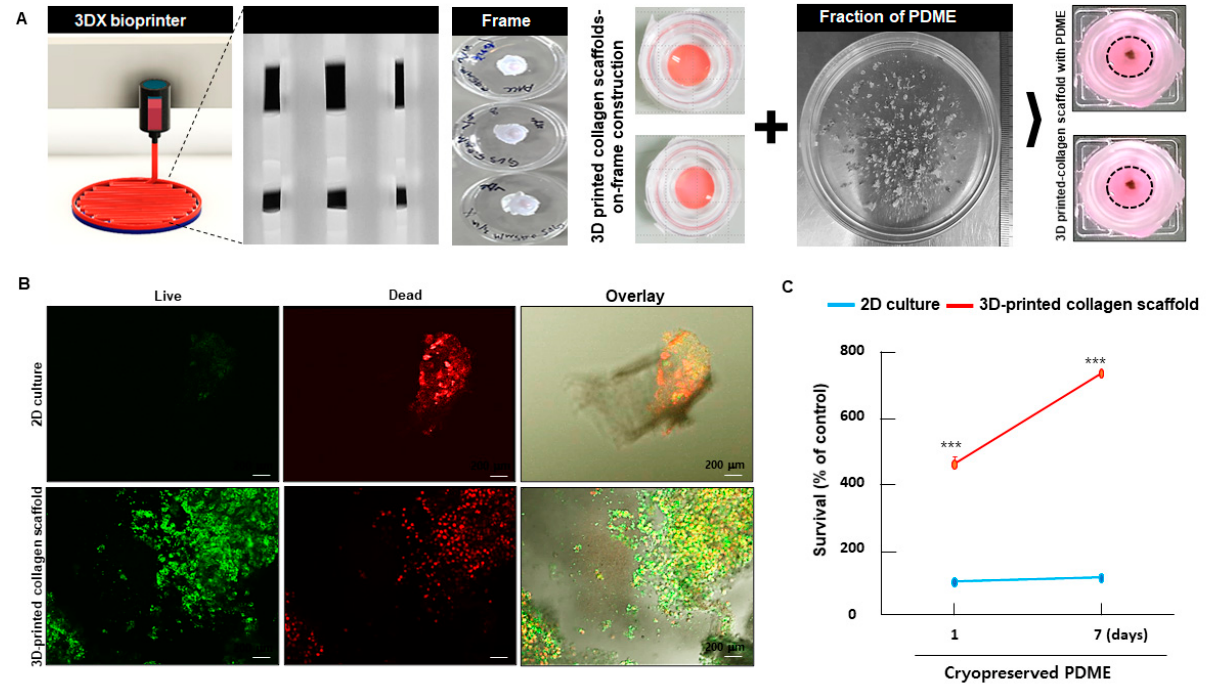
Figure 2. The effects of 3D-printed collagen scaffolds on 3D culture model of cryopreserved PDME. ( A ) Manufacturing process of 3D-printed collagen scaffolds loaded with cryopreserved PDME. Two layers of collagen-on-frame construction were printed by a 3DX bioprinter. ( B ) Confocal images for visualizing live (green) and dead (red) labeled cells in 2D- cultured-and 3D-printed collagen scaffolds loaded with cryopreserved PDME. Scale bars, 200 µ m. ( C ) Graph to calculate the proliferation of 2D-cultured and 3D-printed collagen scaffolds loaded with cryopreserved PDME after the indicated time points. All data were obtained from three independent experiments, and values represent the mean ± SD. For all groups, *** p < 0.001 versus 2D-cultured at the indicated time points using Student’s t -test.